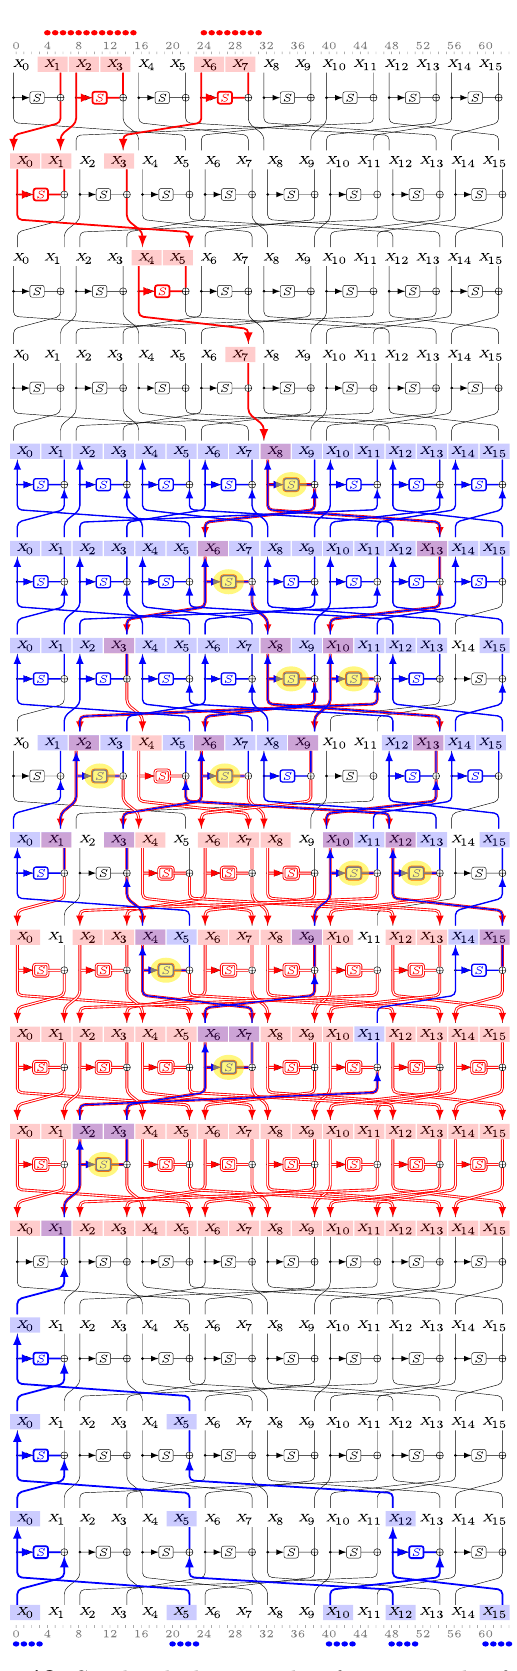
Figure 13: Sandwich distinguisher for 16 rounds of TWINE